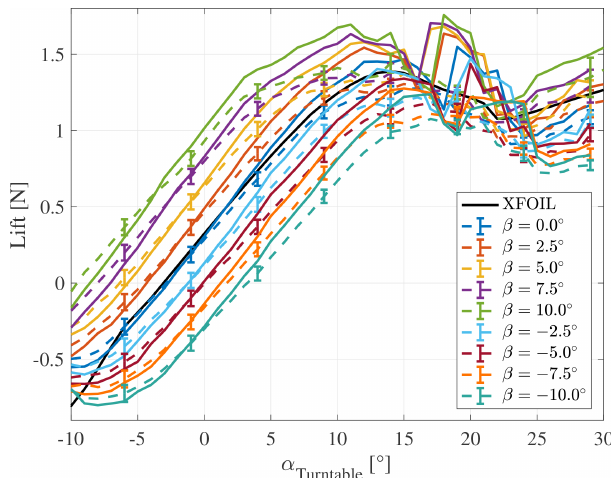
Figure 6. Steady polar curves. Comparison between force balance (dashed lines) and full pressure port integration (solid lines). Error bars correspond to the standard deviation. Furthermore, the XFOIL calculation is shown as the solid black line.